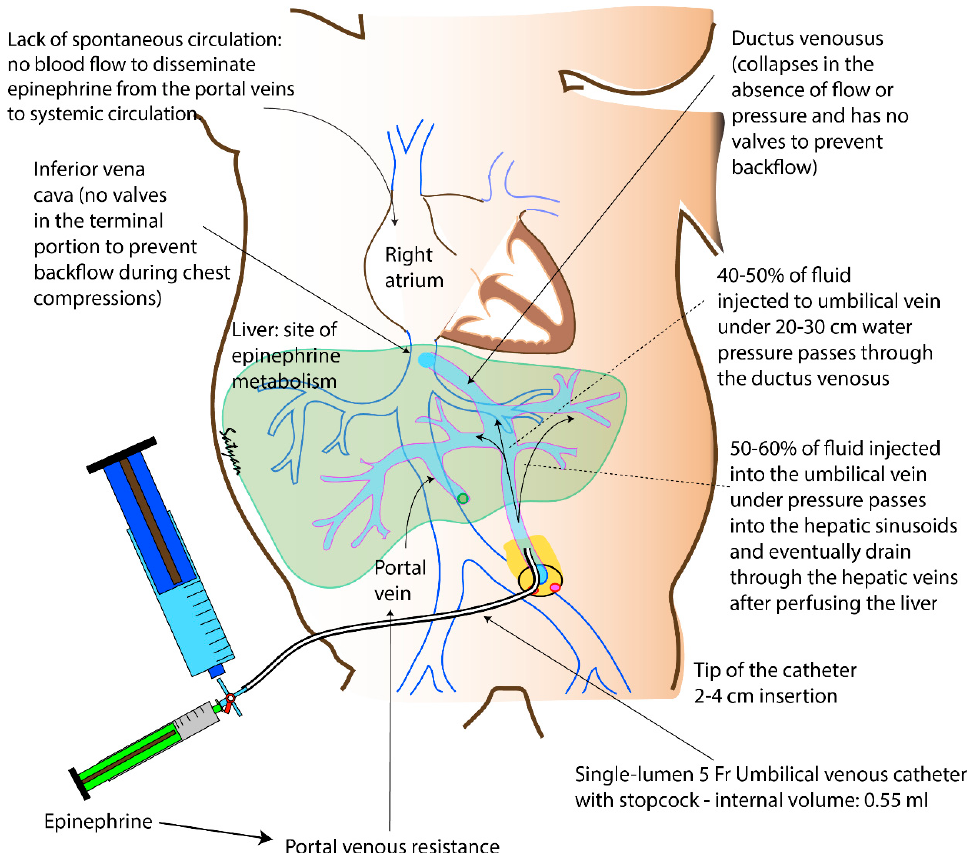
Figure 3. Causes for poor bioavailability and e ffi cacy of epinephrine administered through a low umbilical venous catheter (UVC). The internal volume of a 5 Fr UVC with a stopcock is 0.55 mL. A flush of 0.5–1 mL will clear the catheter and deposit epinephrine in the umbilical vein. In the presence of adequate pressure and flow into the umbilical vein, 40–50% of administered fluid passes through the ductus venosus [30]. In the absence of umbilical flow (as in cardiac arrest), the inlet of the ductus venosus narrows. The terminal portion of the inferior vena cava and ductus venosus do not have valves and backpressure from chest compressions can potentially cause back-flow. Epinephrine also increases portal venous resistance. The liver is also a major site of epinephrine breakdown. Right atrial delivery of a vasopressor can be enhanced by (a) catheter placement in the right atrium (not feasible in the delivery room); (b) quick flush with a mini-bolus to open up the ductus venosus and